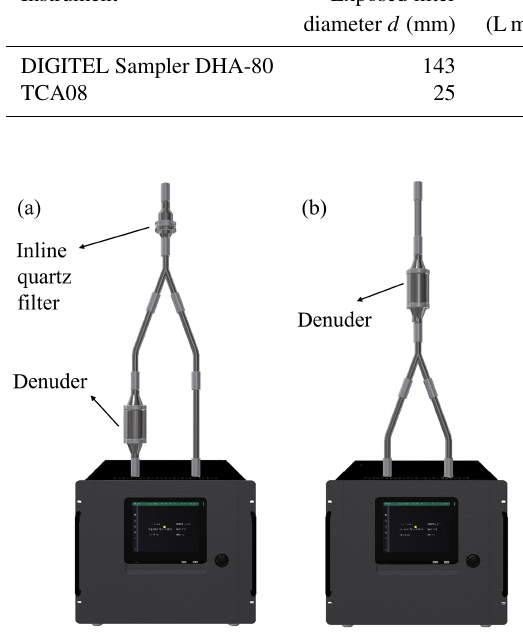
Figure 3. TCA08 setup when (a) sampling and (b) performing de- nuder efficiency test. Note that the tubing length is identical in both setups. This permits the test to be performed at a permanent instal- lation without disturbing the inlet